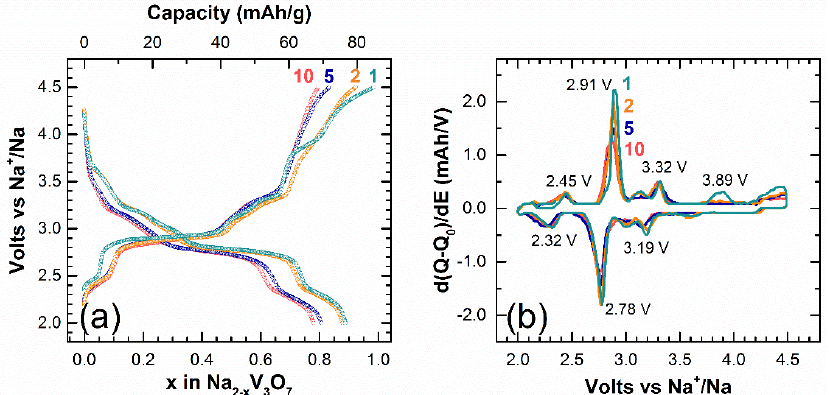
Figure 2. ( a ) Voltage vs. composition profiles between 4.5 V and 2.0 V at a rate of C/20 and ( b ) corresponding derivative curves. The 1st, 2nd, 5th, and 10th cycles are respectively in cyan, orange, blue, and red.